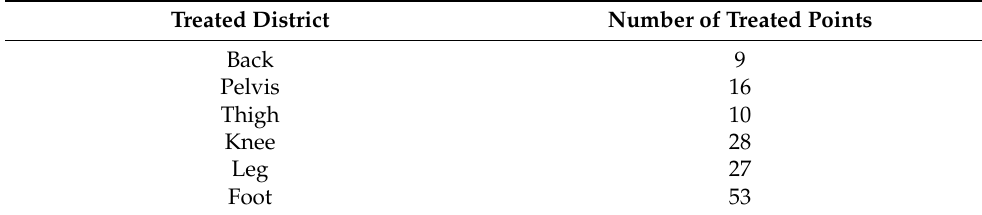
Table 1. Distribution of treated points.